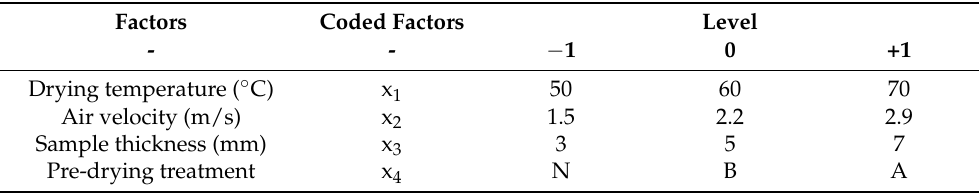
Table 1. Factors and actual level corresponding with the coded